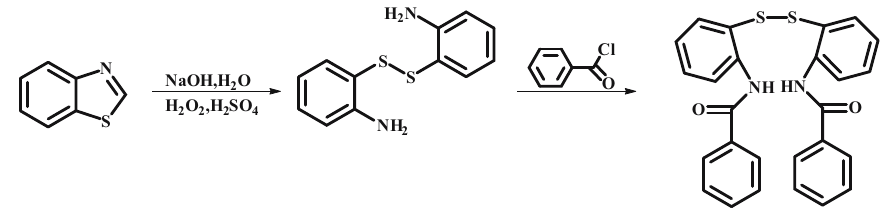
Figure 2: Benzothiazole synthesis